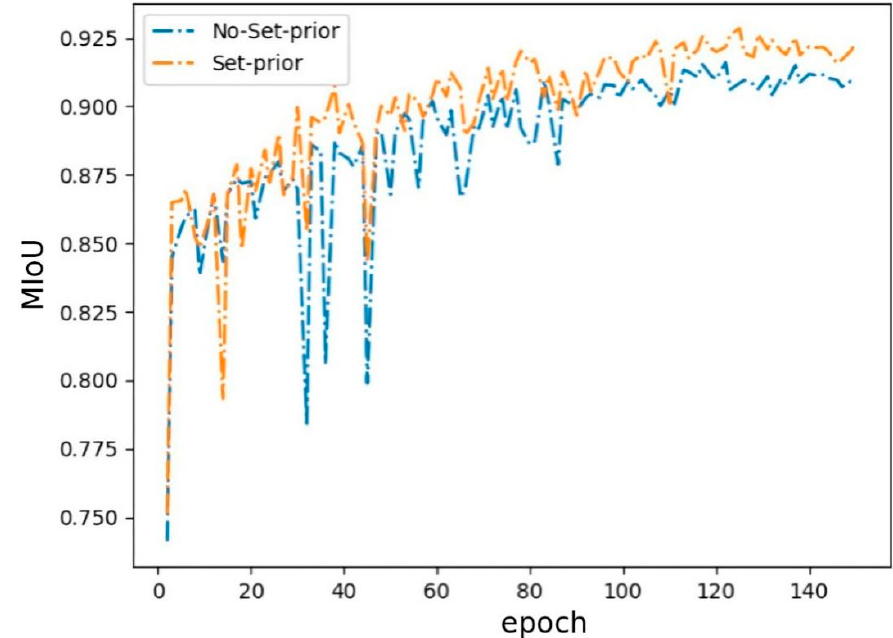
Figure 4. Results of the Set Prior Prediction ablation experiment.